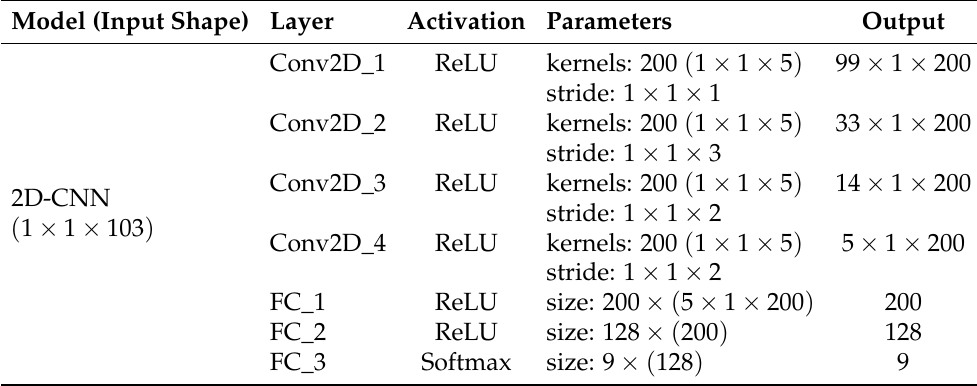
Table 1. The Deep Earth architecture utilized for hyperspectral image segmentation.